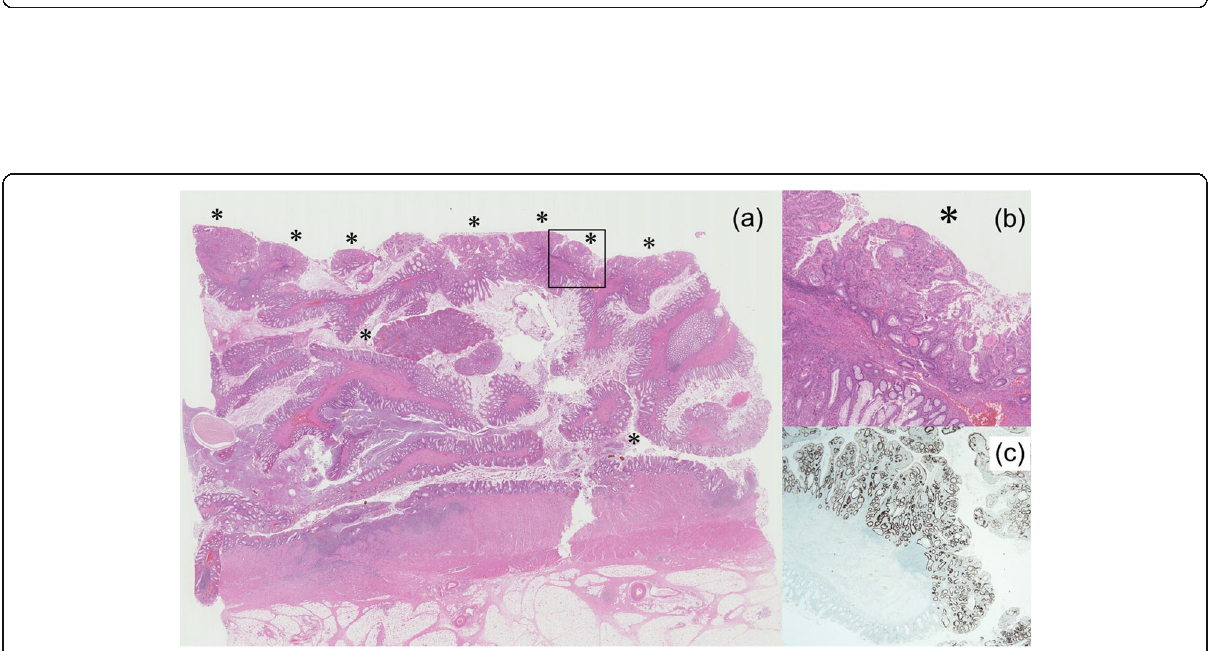
Fig. 4 Histopathological study of filiform polyposis and adenocarcinoma (hematoxylin-eosin and p53-immunohistochemistry staining). Histopathological findings revealed that the worm-like polyps were filiform polyposis; dilated blood vessels, fibrovascular cores, and infiltrated neutrophils and lymphoid cells were seen in submucosal tissue of the polyp axis ( a , × 5). Furthermore, well-differentiated to moderately differentiated tubular adenocarcinoma developed on the filiform polyposis. They mostly existed in the intramucosal area and were scattered uniformly on the surface of filiform polyposis (asterisks). The square part of Fig. 4a. The adenocarcinoma developed in the intramucosal area of the filiform polyposis ( b , × 50). Immunohistochemistry using anti-p53 verified that the normal mucosa of filiform polyposis absence of abnormal p53 expression, while the adenocarcinoma on filiform polyposis showed an abnormal p53 nuclear expression ( c , ×